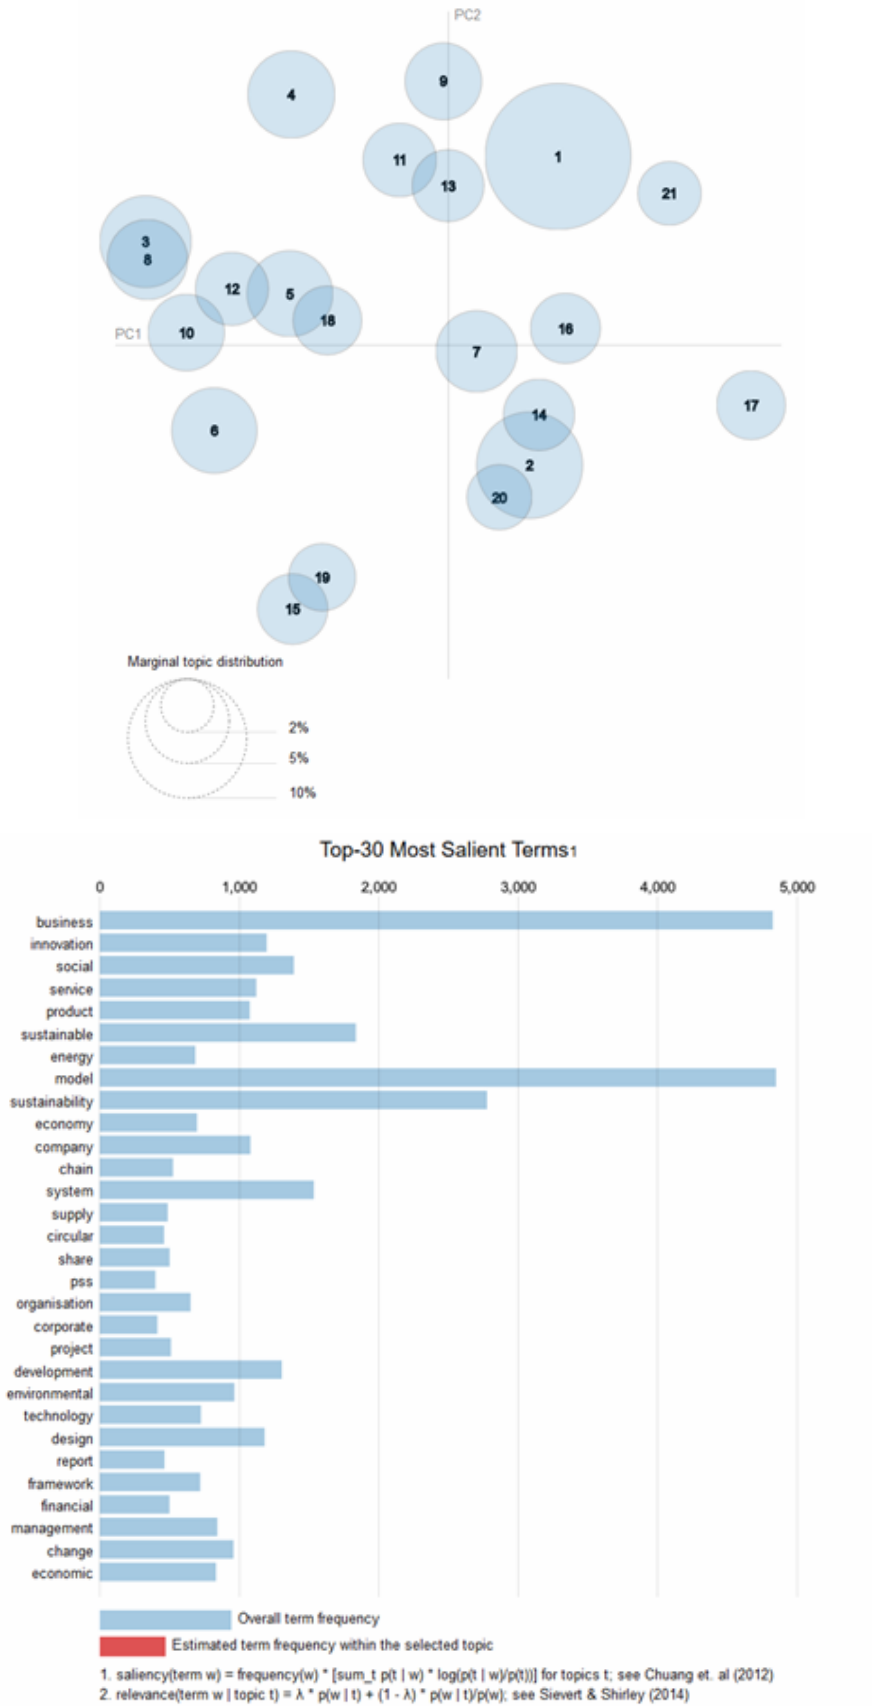
Figure 3. Intertopic distance map (a) and the list of Top-30 most salient terms (b) for SBM